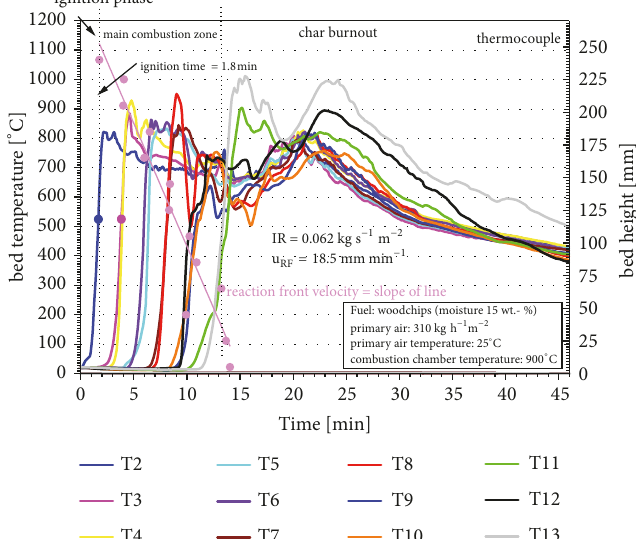
Figure 3: Temperature distribution and the position of the reaction front in the fuel bed [11].